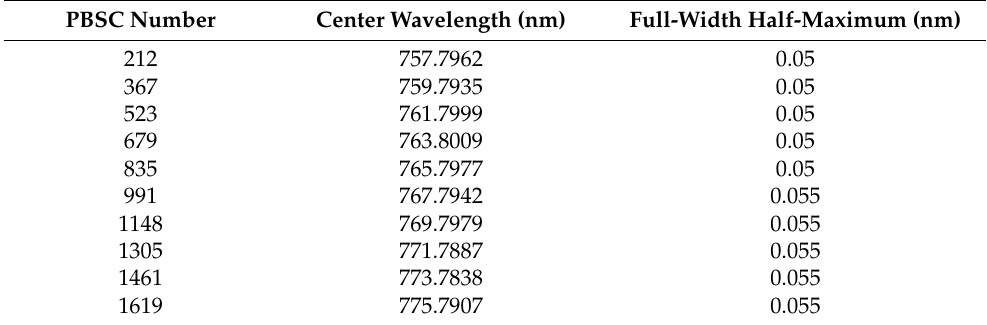
Table 4. Spectral calibration results of molecular oxygen A-band with observation channel (channel 3).